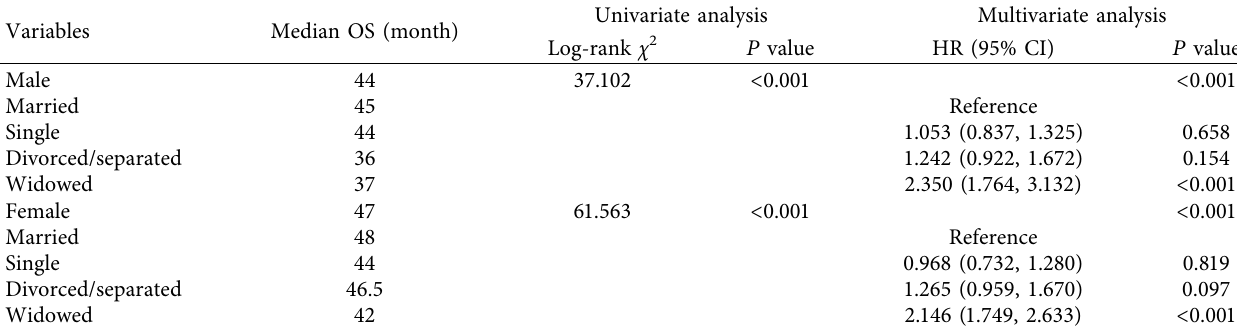
Table 4: Univariate and multivariate analysis for evaluating the influence of marital status on OS according to gender.